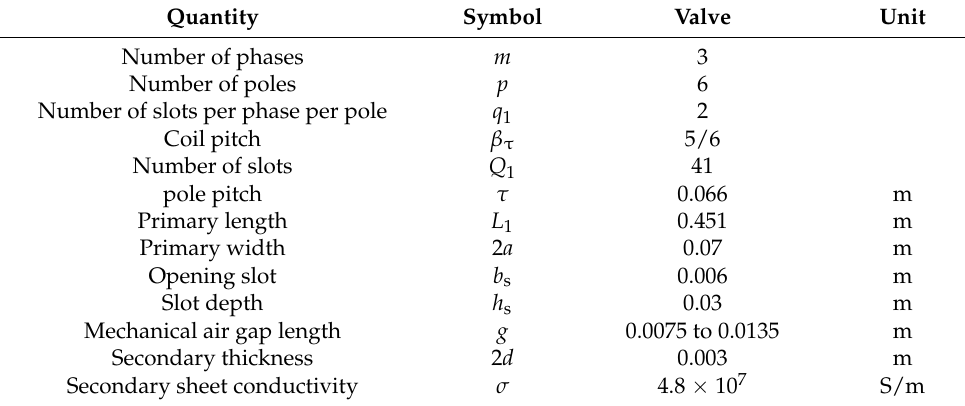
Table A1. Specifications of